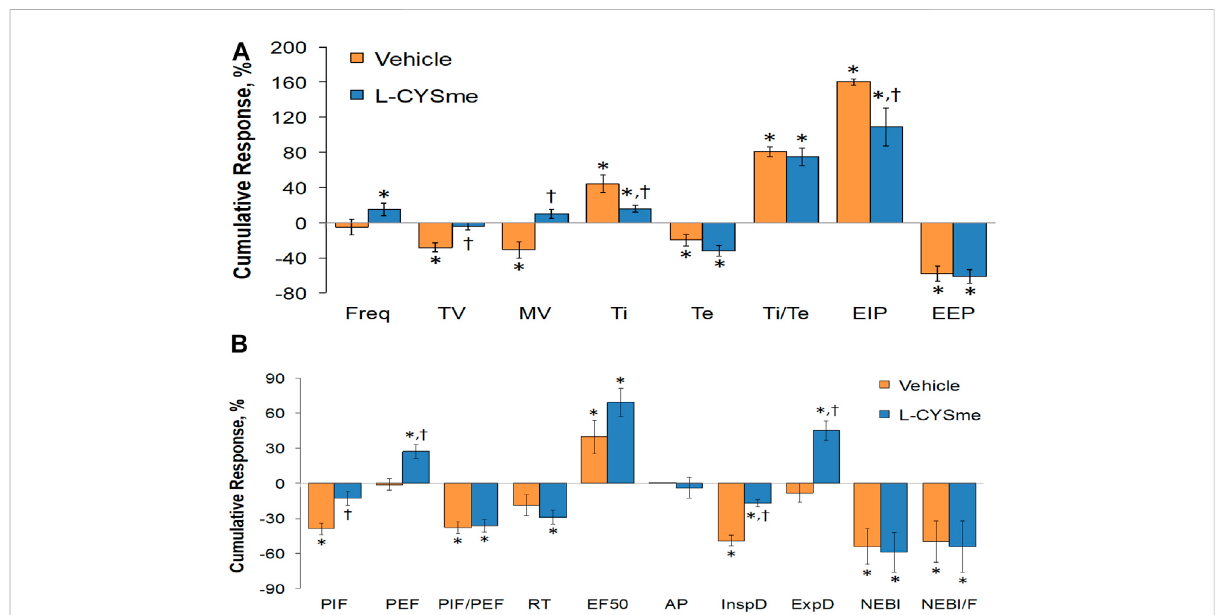
FIGURE 8 Cumulativechangesinventilatoryparametersrecordedoverthe15-minperiodfollowingthe fi rstinjectionofvehicleorL-cysteinemethylester (L-CYSme, 500 μ mol/kg, IV) in rats that had been injected with morphine (10 mg/kg, IV). Panel (A) frequency of breathing (Freq), tidal volume (TV), minute ventilation (MV), inspiratory time (Ti), expiratory time (Te), Ti/Te, end inspiratory pause (EIP), and end expiratory pause (EEP). Panel (B) peak inspiratory fl ow(PIF),peakexpiratory fl ow(PEF),PIF/PEF,relaxationtime(RT),expiratory fl owat50%ofexpiredtidalvolume(EF 50 ),apneicpause (AP), inspiratory drive (InspD, TV/Ti), expiratory drive (ExpD, TV/Te), non-eupneic breathing index (NEBI), and NEBI/freq (NEBI/F). Data are presented as mean ± SEM. There were 6 rats in each group. * p < 0.05, signi fi cant difference from Pre values. † p < 0.05, L-CYSme versus